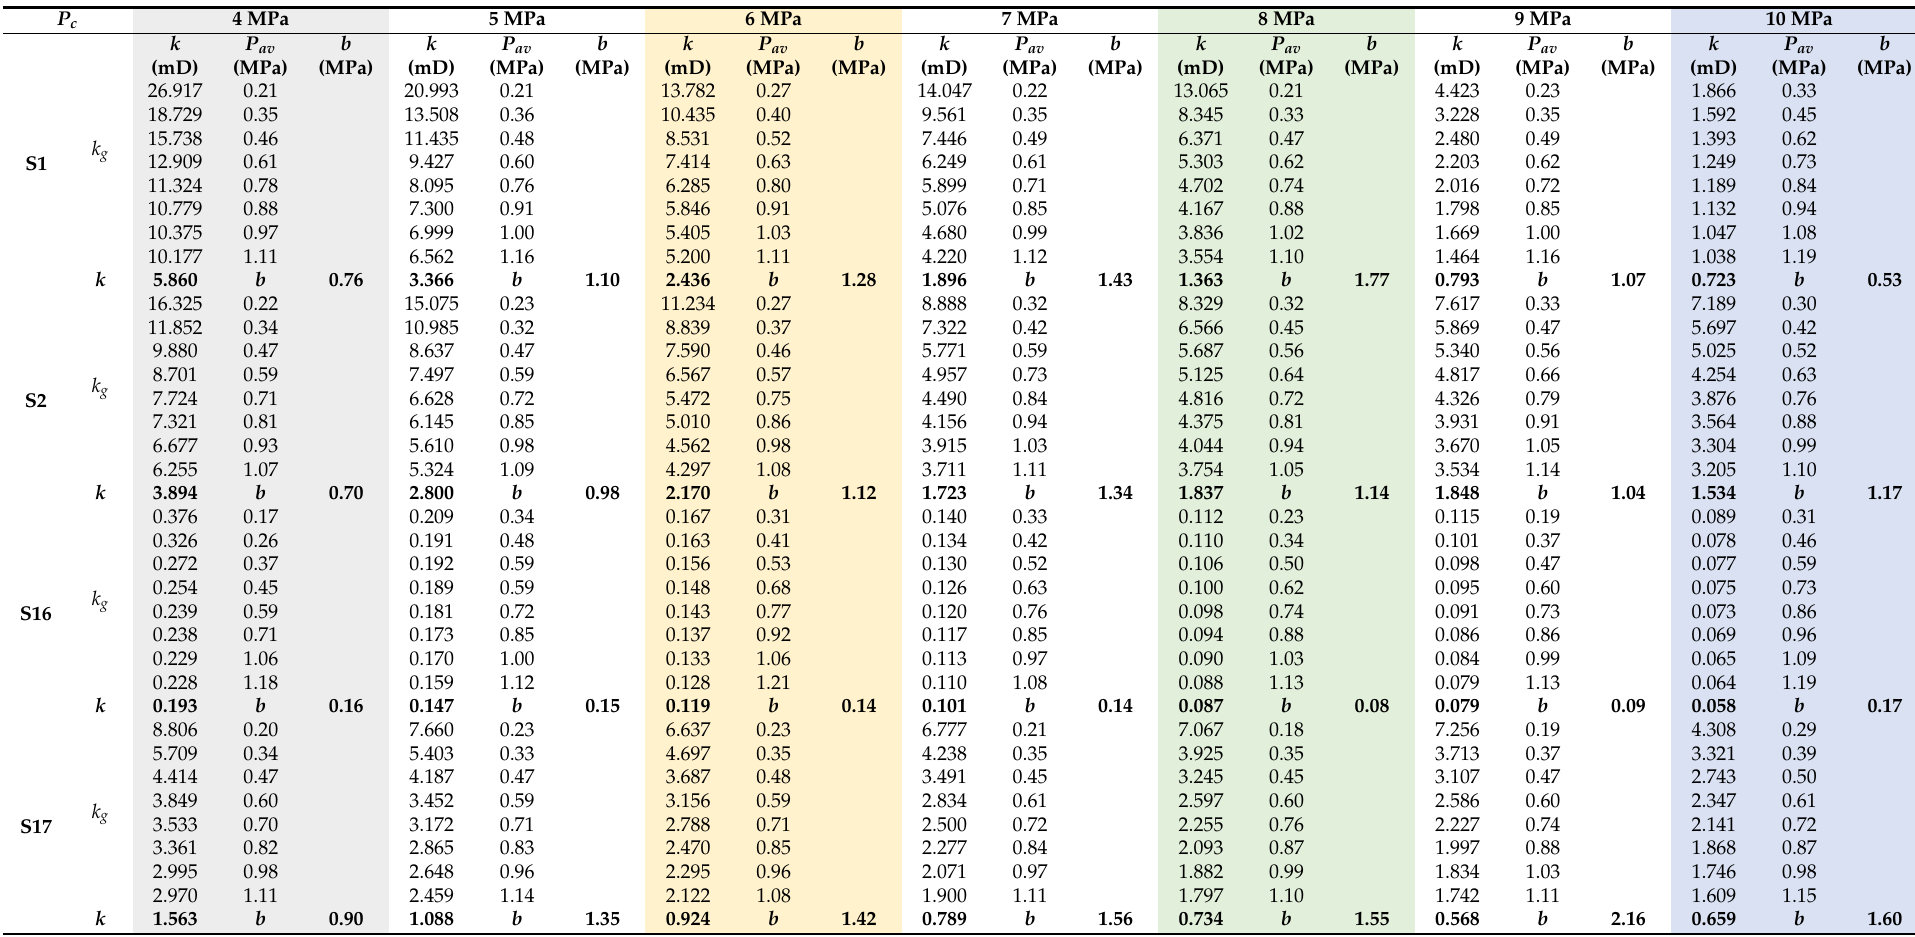
Table A1. All permeability results with parameters as defined in the main